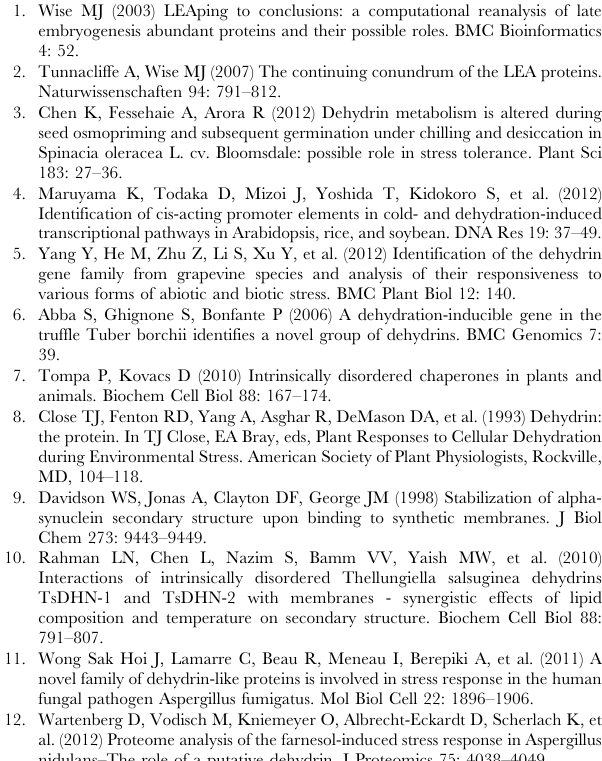
probes and the sizes of expected hydridizing fragments are shown. B: Southern hybridization of genomic DNA from wild-type Abra43 (WT) and transformants. Each DNA was digested with either Sac I or Pst I and the blot hybridized with the Abdhn1 , Abdhn2 , or Abdhn3 probes. Figure S2 AbDHN2 amino acid sequence. The eleven amino acids repeat at the N-terminal end of the sequence is indicated in red and blue characters. The five conserved DPR motifs are indicated in bold characters. Residues in italic are absent in the ß isoform and the underlined residue corresponds to a potential phosphorylated serine present only in the a isoform. Figure S3 Constitutive GFP expression in an A. brassi- cicola mutant. Observation was performed using confocal microscopy. Bars = 10 m m. Figure S4 Comparison of growth rates of the wild-type strain and dehydrin-like deficient mutants in solid and liquid nutritive media. A: In vitro growth tests were carried out on PDA plates. Growth was recorded after 7 days of incubation at 24 u C. B: Nephelometric monitoring of the growth of different genotypes. Conidia from the wild-type and mutants were used to inoculate microplate wells containing standard PDB medium. Growth was automatically recorded for 25 h at 25 u C using a nephelometric reader. The unit of the Y-axis corresponds to the Relative Nephelometric Unit (RNU). Lag time and maximal growth rate variables were calculated from the growth curves using a calculation method described by Joubert et al [19]. For each parameter, Student’s T-test was used to assess significant difference between mutants and parental isolate.